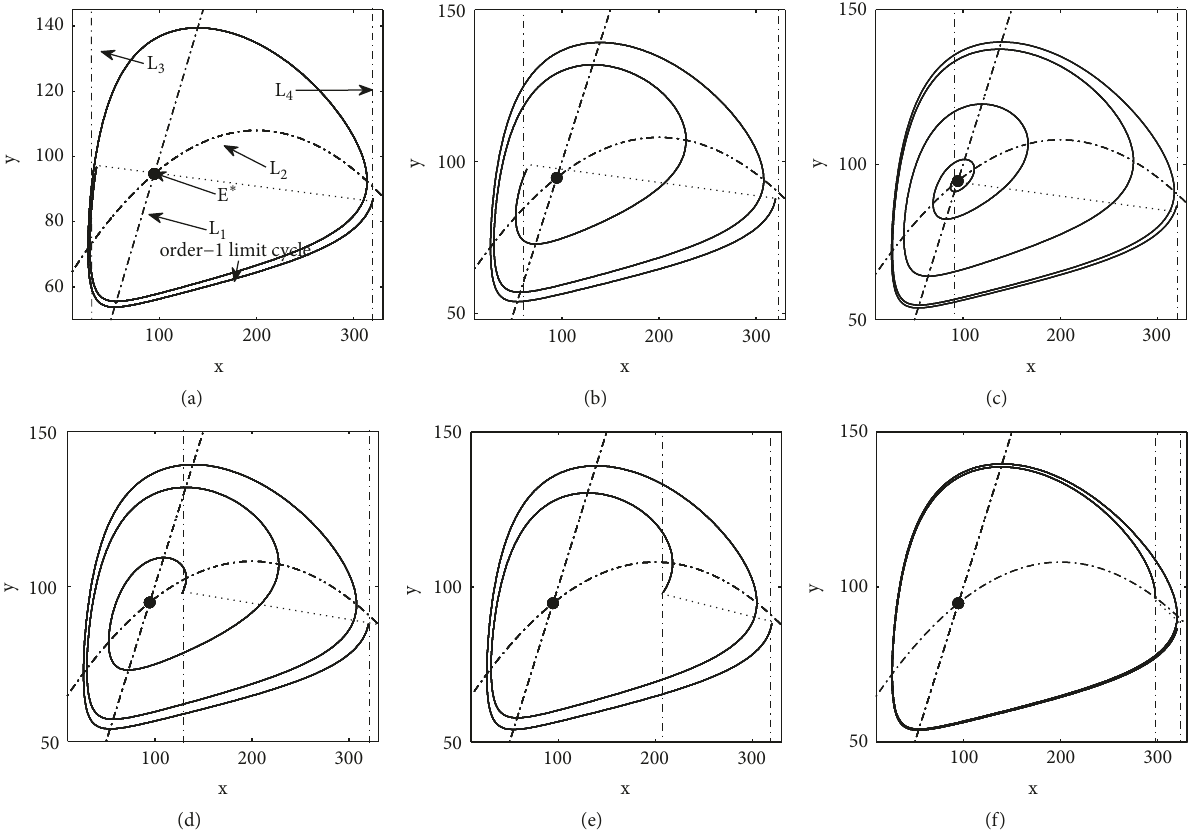
Figure 8: Number of discontinuity points of Poincar´e map for case (𝑆𝐶 4 ) with 𝑟 = 0.3 , 𝐾 = 500 , 𝑚 = 0.5 , 𝐴 = 100 , 𝑠 = 0.03 , ℎ = 1 , 𝐸𝑇 = 320 , 𝜎 = 2 , and 𝑞 = 0.3 . (a) 𝛿 = 0.89 ; (b) 𝛿 = 0.8 ; (c) 𝛿 = 0.7 ; (d) 𝛿 = 0.6 ; (e) 𝛿 = 0.35 , and (f) 𝛿 = 0.07